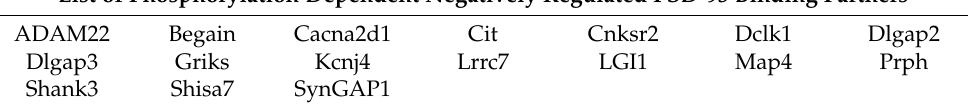
Agap3 Dlg1 Dlgap1 Dlg4 Dlgap4 Grin1 Grin2a Grin2b Grik5 Iqsec2 Nrcam Rtn3 Table 2. Phosphorylation dependent negatively regulated PSD-93 binding partners. LC-MS/MS data were sorted according to two criteria: 1. the sample-control vs. IgG-control ratio was greater than 10:1, and 2. binding with PSD-93 upon calyculin A stimulation was lower than that under the sample-control condition or after Y-27632 stimulation. The proteins in the box were negatively regulated upon PSD-93 phosphorylation by